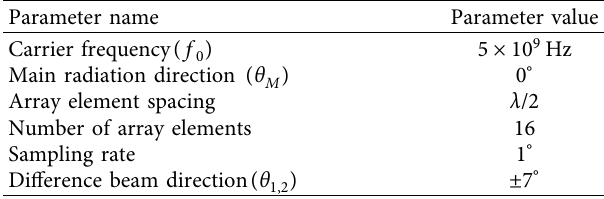
Table 1: Linear array parameter initialization.